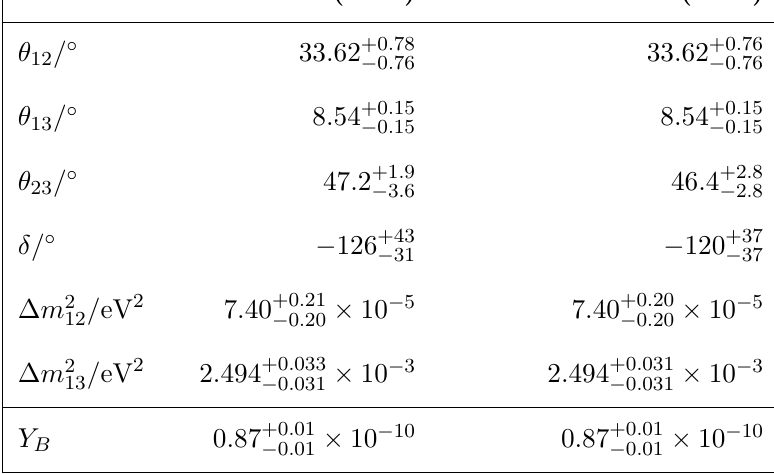
Table 1 . Global (cid:12)t values from NuFit3.2 [9, 10] in the case of normal ordering, along with latest 1 (cid:27) bounds on Y B from Planck satellite [53]. The third column details the assumed values which we actually use in our analysis, which respect the one sigma asymmetric ranges in NuFit3.2.